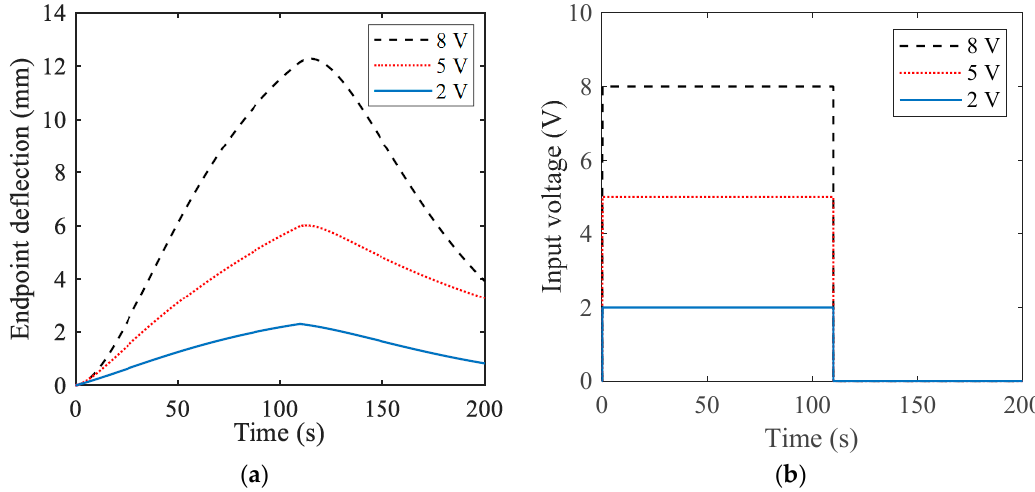
Figure 5. ( a ) Response of the actuators with the same pattern and dimensions to ( b ) different input voltages’ magnitudes. The results are averaged over the three trials.